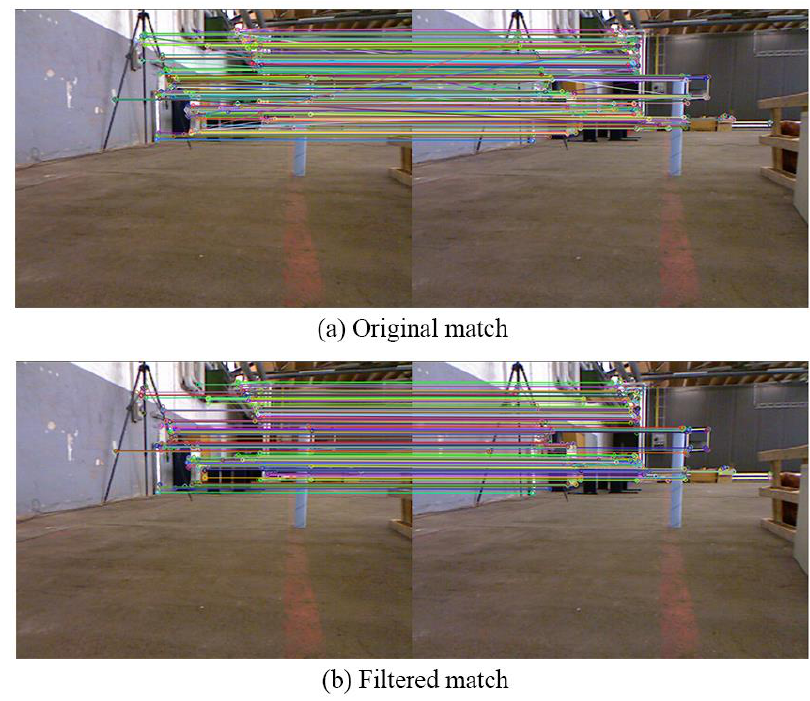
Figure 5. Effect of ORB feature extraction and matching.